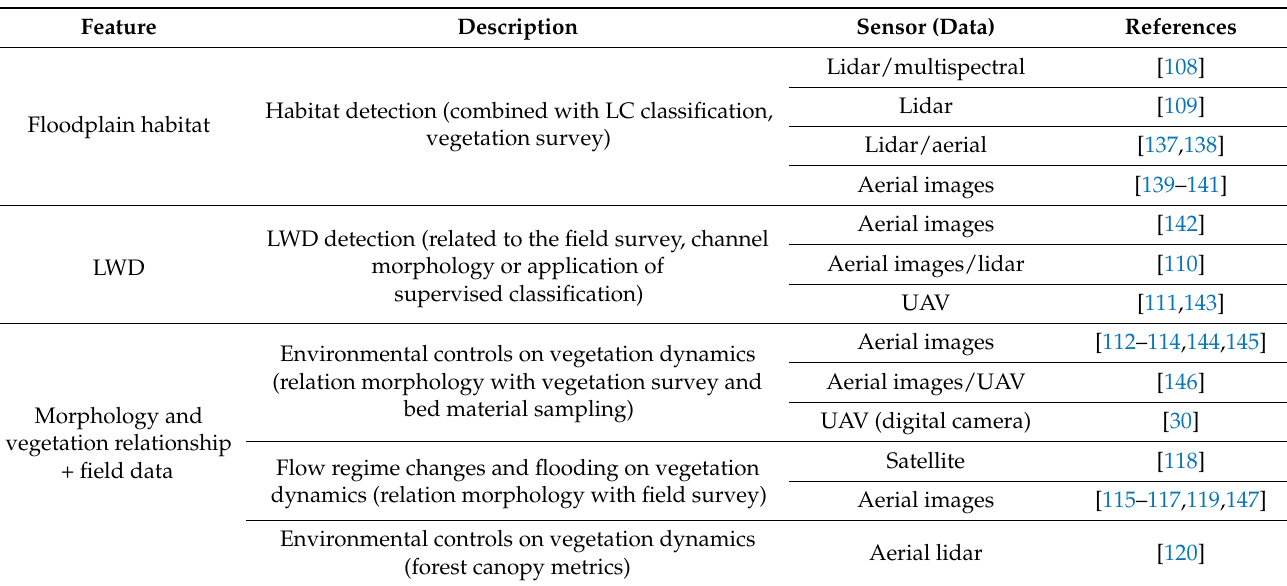
Table 2. Detection and classification of river morphology and vegetation with a detailed field survey of vegetation and soil properties. Studies are sorted based on a short description of the methodologies and sensors